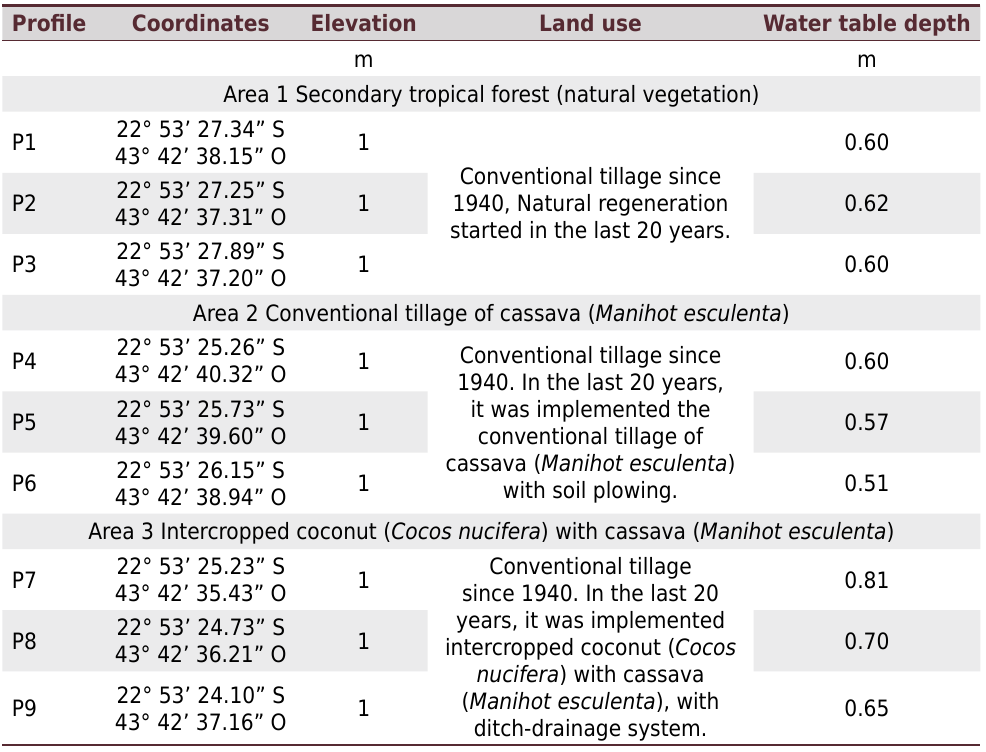
Table 1. Profiles location and characteristics of the studied areas located in the municipality of Rio de Janeiro, Brazil Profile Coordinates Elevation Land use Water table depth m